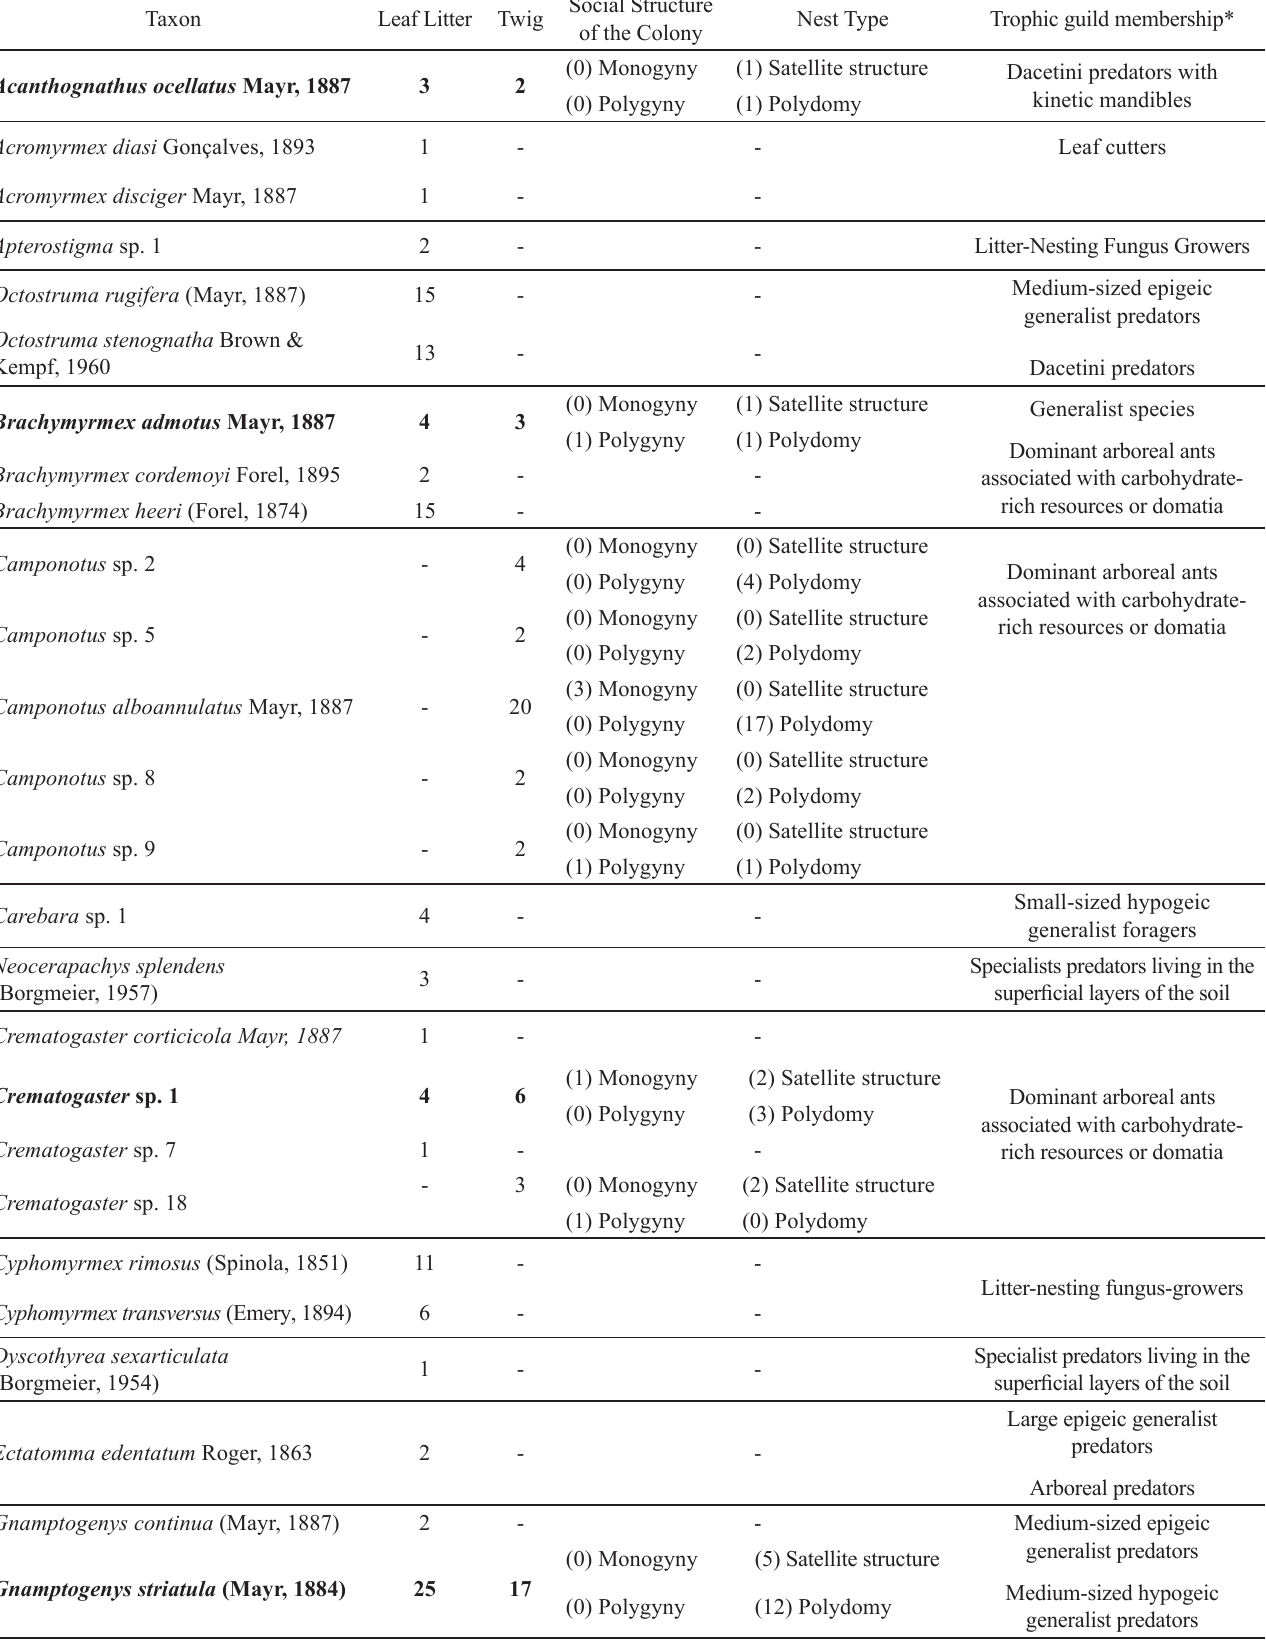
Table 1. List of taxa recorded from leaf litter and twigs, with social structure of the colony, nest type, and guild membership. The total number of nests is shown in parentheses. Species in bold font were recorded both in the leaf litter and in